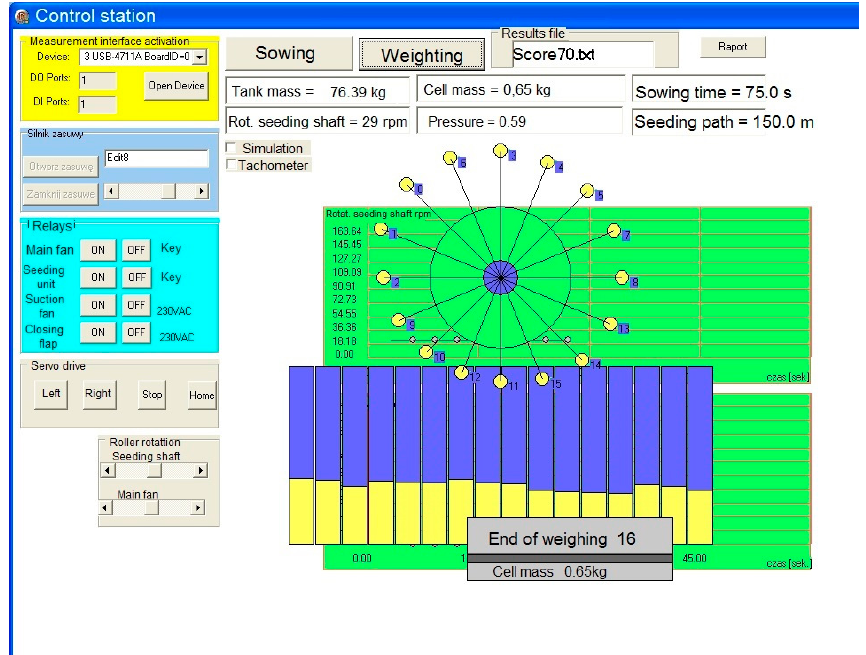
Figure 8. A dialogue form of the program controlling the measuring facility.